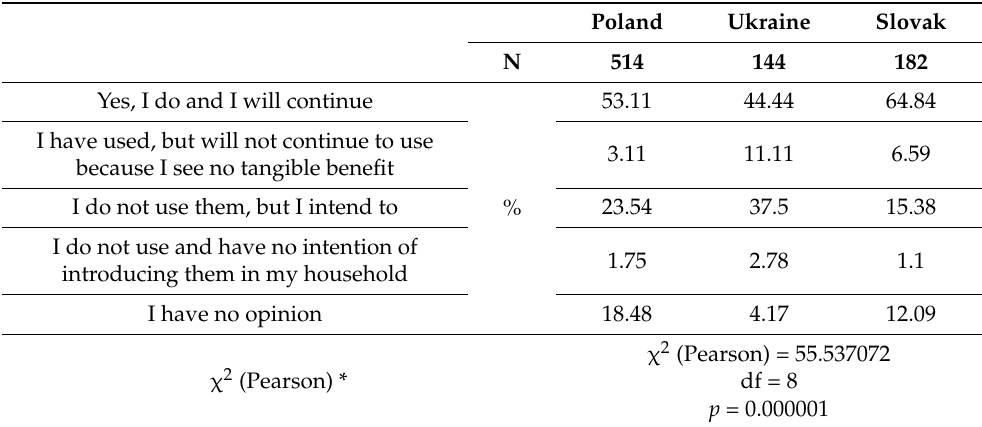
Table 12. Level of implementing ZW principles according to respondents from Poland, Ukraine and